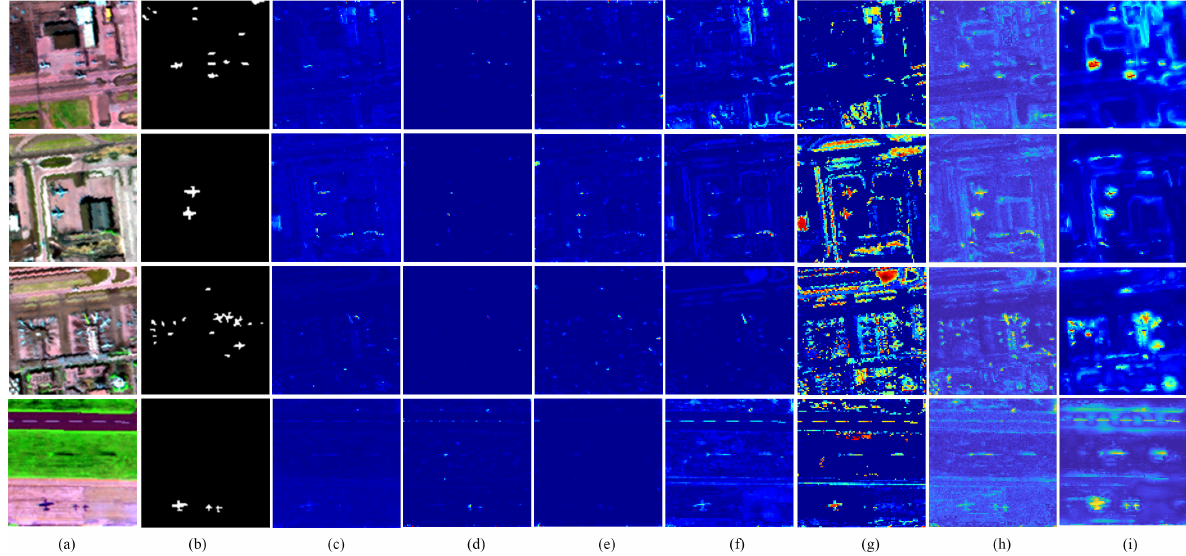
Figure 3. Detection maps of the compared AD methods.The sample images from top to bottom are airport-1, airport-2, airport-3, and airport-4, respectively. ( a ) Color composites of airport scene; ( b ) Reference map; ( c ) GRX; ( d ) LRX; ( e ) CRD; ( f ) LRASR; ( g ) ADLR; ( h ) KIFD; ( i )